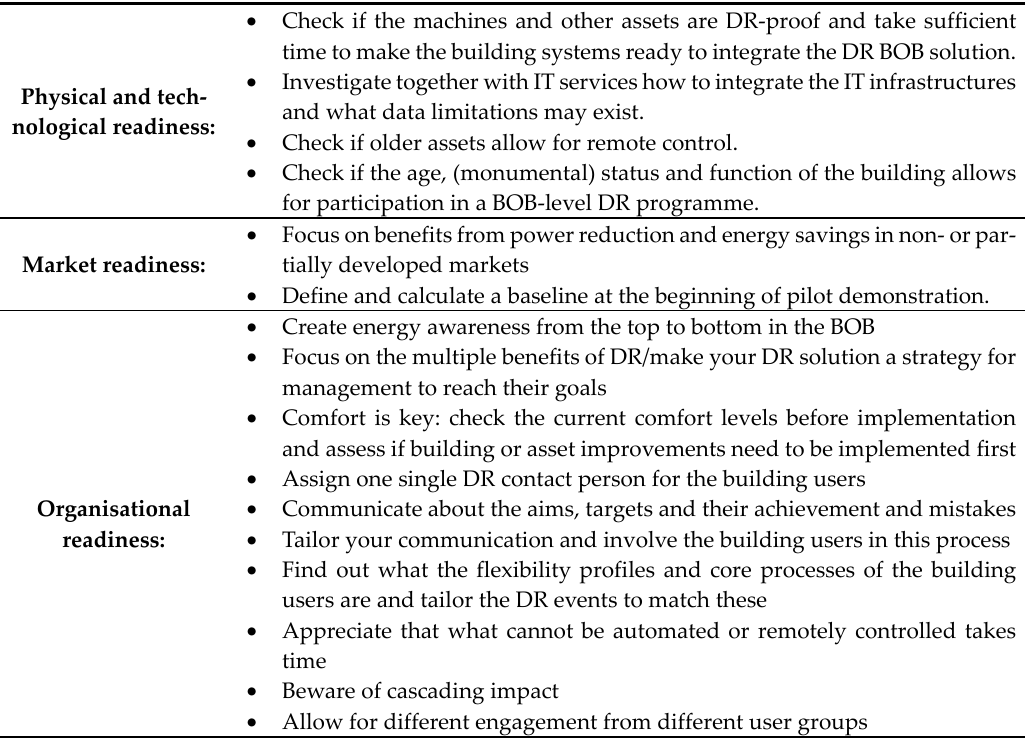
Table 3. Recommendations for each readiness